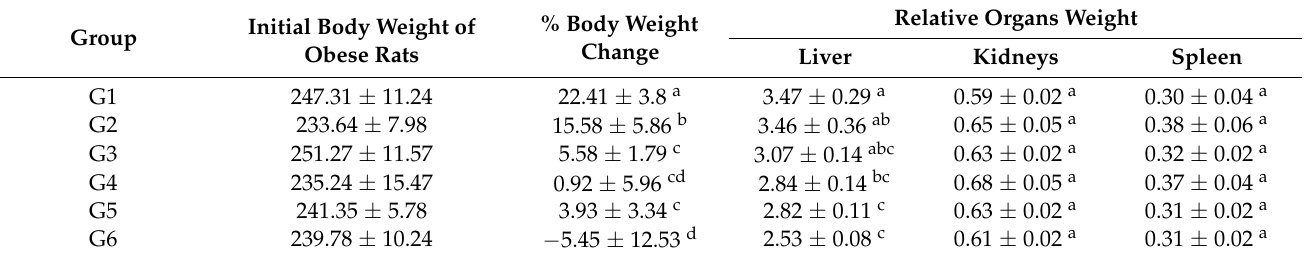
Table 1. Effect of FCM, FCM-D, and intermittent on relative organs weight in obese rats fed a high-fat diet for 6 weeks, n =